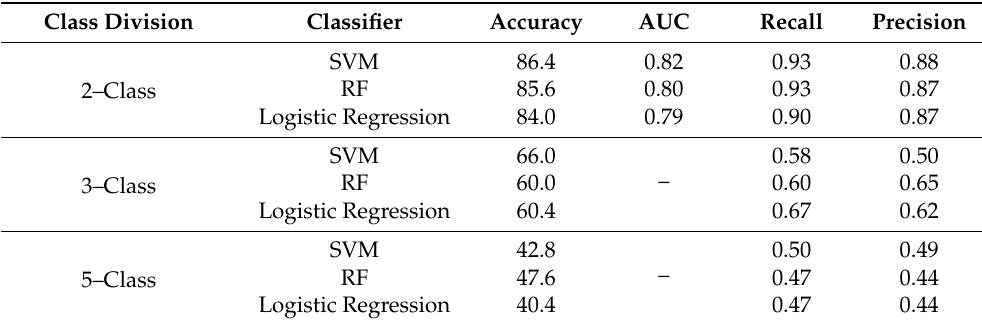
Table 2. Classification performance analysis—no feature extractor.